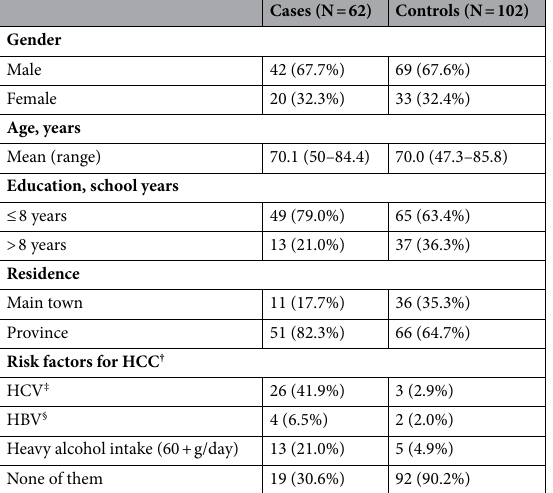
Table 1. Socio-demographic variables and risk factors for hepatocellular carcinoma (HCC) in cases and controls. † p < 0.01. ‡ HCV infection alone + HCV and HBV co-infection + HCV infection and heavy